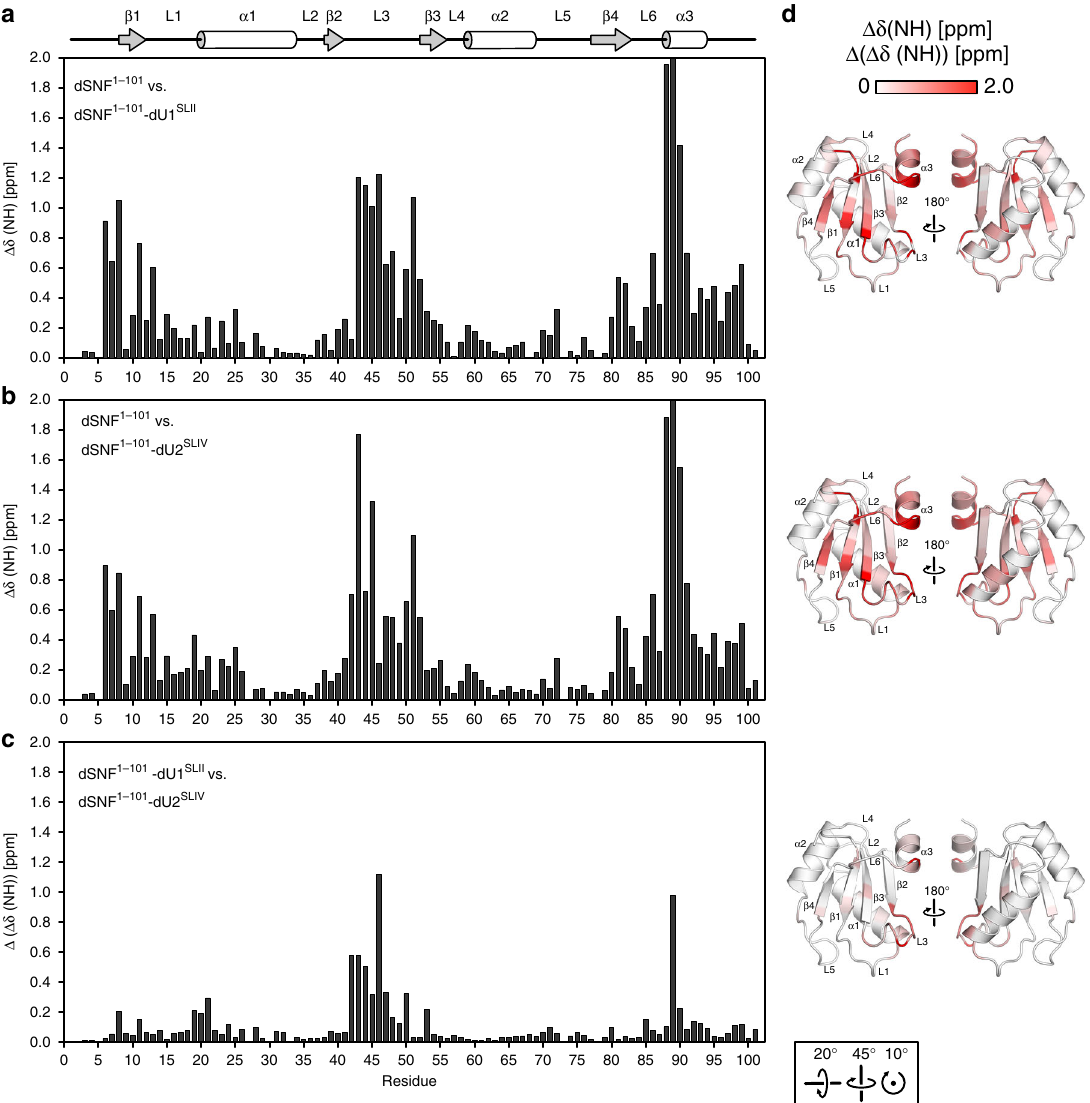
Fig. 4 dSNF 1 – 101 -RNA NMR chemical shift perturbations. a Backbone amide chemical shift differences between dSNF 1 – 101 and dSNF 1 – 101 – dU1 SLII complex. Δδ = [( Δδ HN) 2 + (( Δδ N) 2 *0.154)] 1/2 . dSNF 1 – 101 at 300 µ M, dU1 SLII at 700 µ M. b dSNF 1 – 101 backbone amide chemical shift perturbations ( Δδ ) upon dU2 SLIV binding. dSNF 1 – 101 at 300 µ M, dU2 SLIV at 1.1 mM. c Difference plot of chemical shift perturbations ( Δ ( Δδ ) = [ Δδ (dSNF 1 – 101 – dU2 SLIV ) – Δδ (dSNF 1 – 101 – dU1 SLII )]). Positions of secondary structure elements are shown on the top. 50 mM KCl, 20 mM sodium cacodylate, pH 6.5, in 90% 1 H 2 O, 10% 2 H Δδ (top and middle) or Δ ( Δδ ) values (bottom) mapped onto the structure of dSNF 1 – 96 . A scale bar is shown 2 O; 23 °C; 700 MHz. d Orthogonal views of on the top. The orientation of the left panels relative to Fig. 1b is shown at the